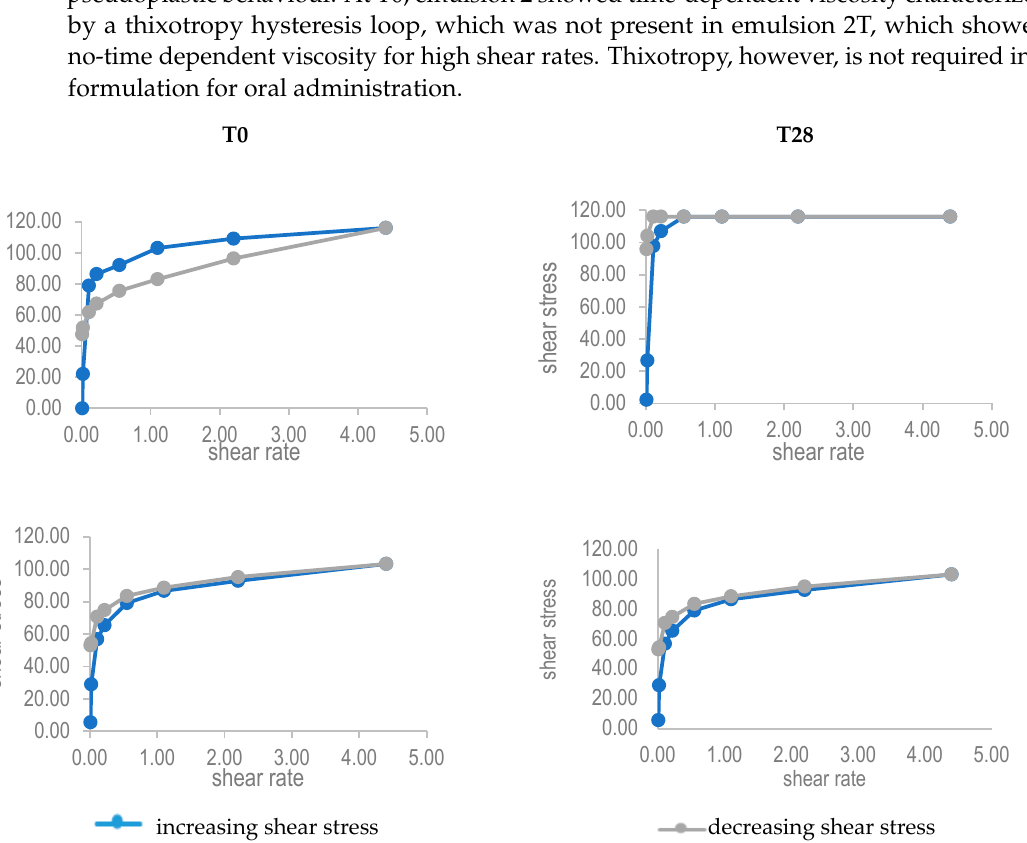
Figure 2. Rheological behaviour of emulsions 2 and 2T.